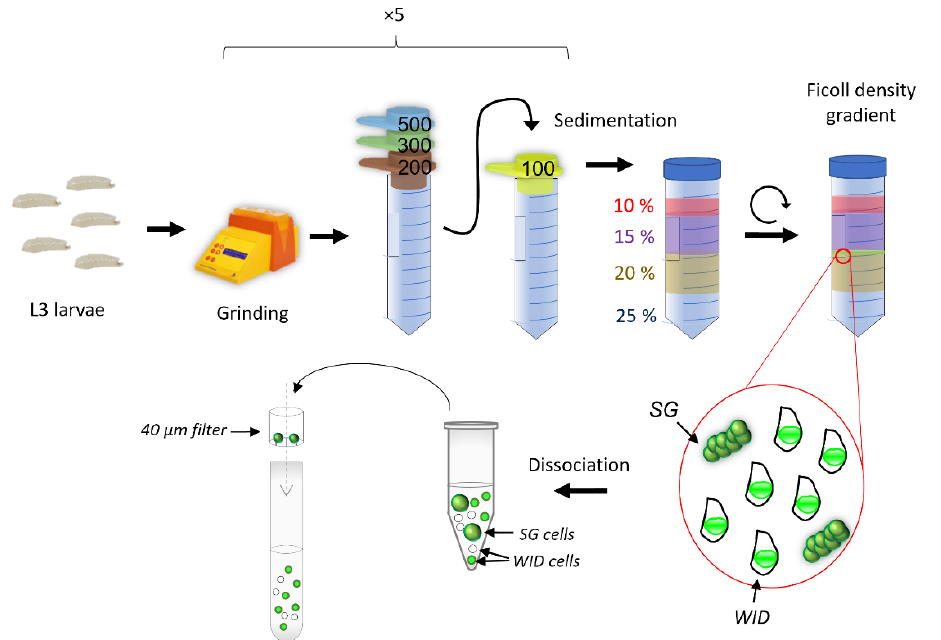
Figure 1. Overview of the mass purification protocol. L3 larvae obtained from synchronized egg-laying are collected en masse using a wash bottle. The larvae were initially ground using a GentleMACS TM (Miltenyi Biotec, Bergisch Gladbach, North Rhine-Westphalia, Germany). The material was then filtered through a series of strainers with decreasing mesh size, allowing the selection of elements between 100 µm and 200 µm. This material is resuspended in 10% ( w / v ) Ficoll and loaded on top of a 15:20:25% ( w / v ) Ficoll gradient. After centrifugation, wing imaginal discs (WID) are found at the 15:20% ( w / v ) interface along with some salivary gland (SG) pieces. After dissociation, filtering the cells through a 40 µm filter is enough to separate salivary gland cells from disc cells.